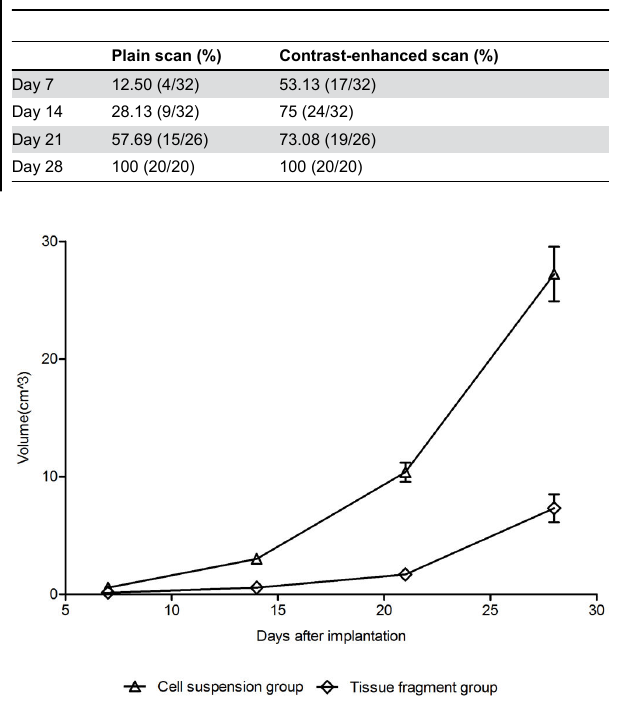
Table 1. Tumor visualization rate on CT scans after implantation.